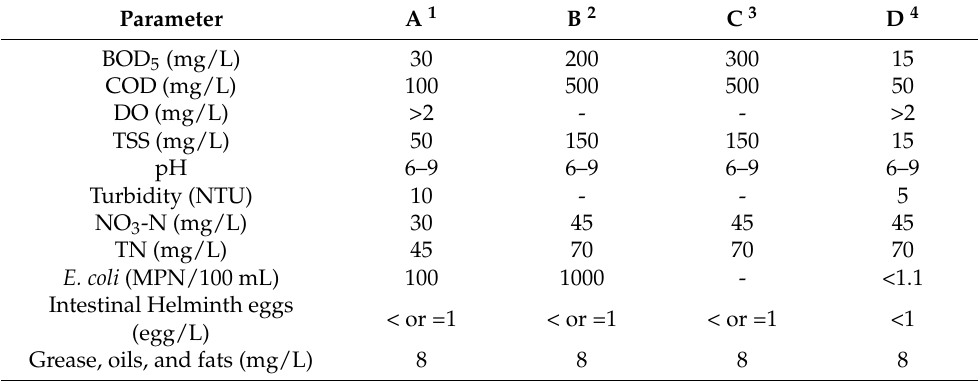
Table 1. The Jordanian standards for treated wastewater reuse in irrigation (JS 893/2006) [1].